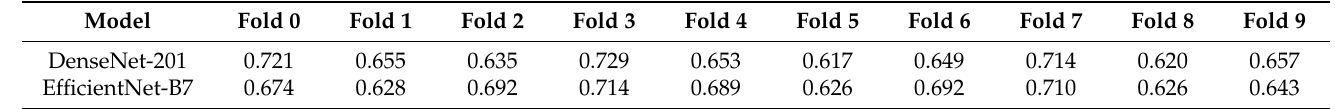
Table 3. Diagnostic precision values predicting the presence of white matter hyperintensity in the 10-fold cross